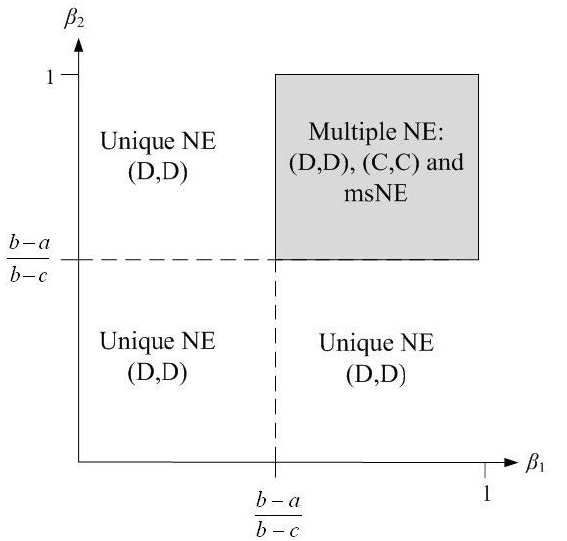
Figure 1. Equilibria in the simultaneous game under complete